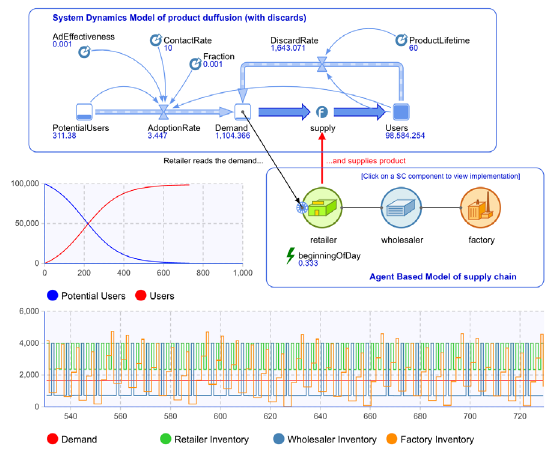
Figure 8. Health Supply Chain Optimization. Source: